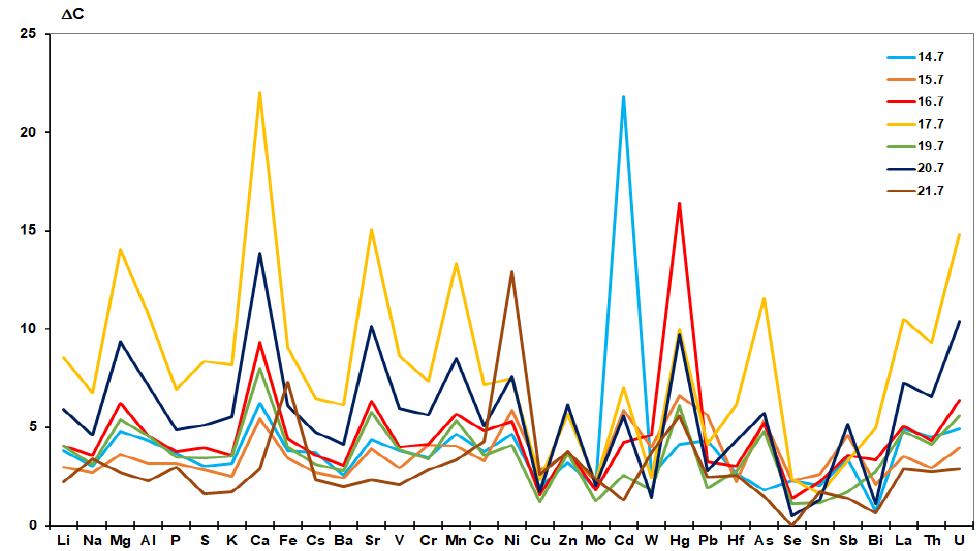
Figure 13. The relative excess of elemental mass concentrations ∆ C (formula 2) for the different days of episode No. 6.